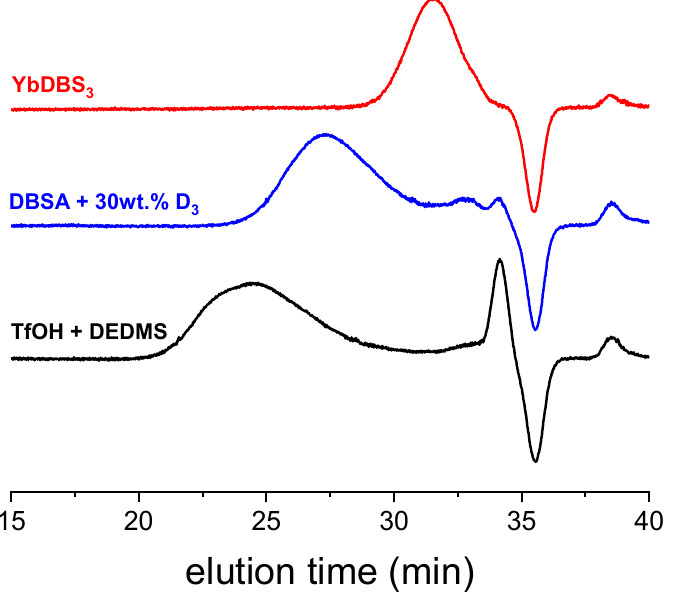
Figure 1. Selected SEC chromatograms of samples polymerized with various acids in the first set of polymeriations. Negative peak at 36 min is due to the flow marker. For the record, D 3 and D 5 were separately analyzed by SEC and came out at 34.5 and 34 min, respectively.